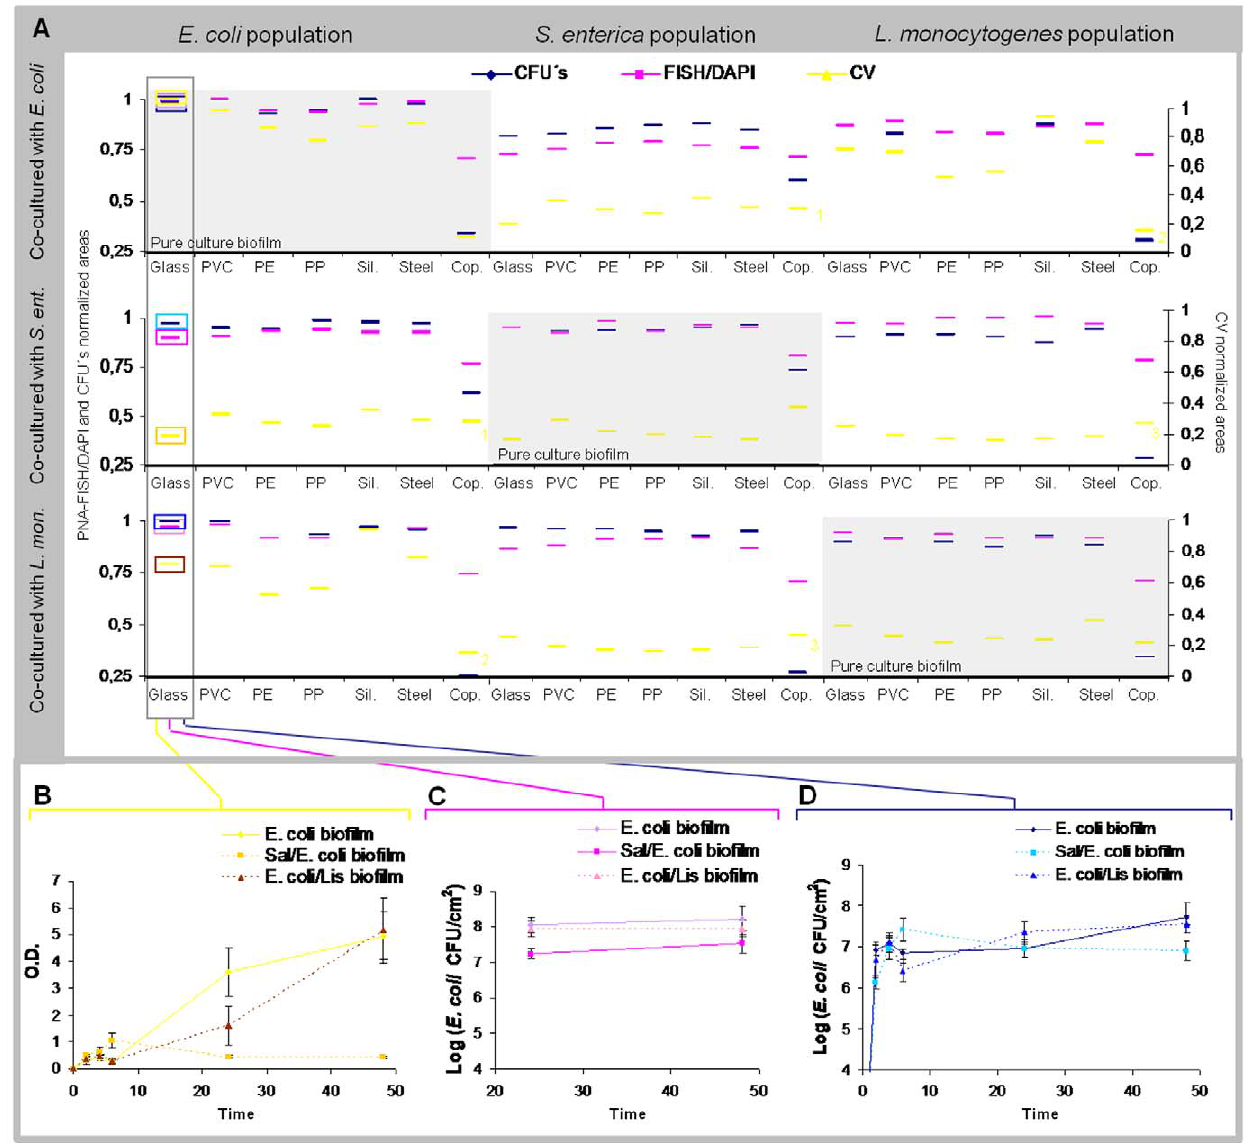
Figure 3. Biofilm formation for single- and dual-species biofilms. On panel A it is possible observe the normalized areas for each biofilm on each adhesion material for cultivability, CV and PNA FISH/DAPI graphs (A). Panels B, C and D are shown as examples of CV, PNA FISH/DAPI and cultivability graphs, respectively, on the glass support. Similar graphs for the remaining supports are provided in the Figures S2, S3, S4 and S5.